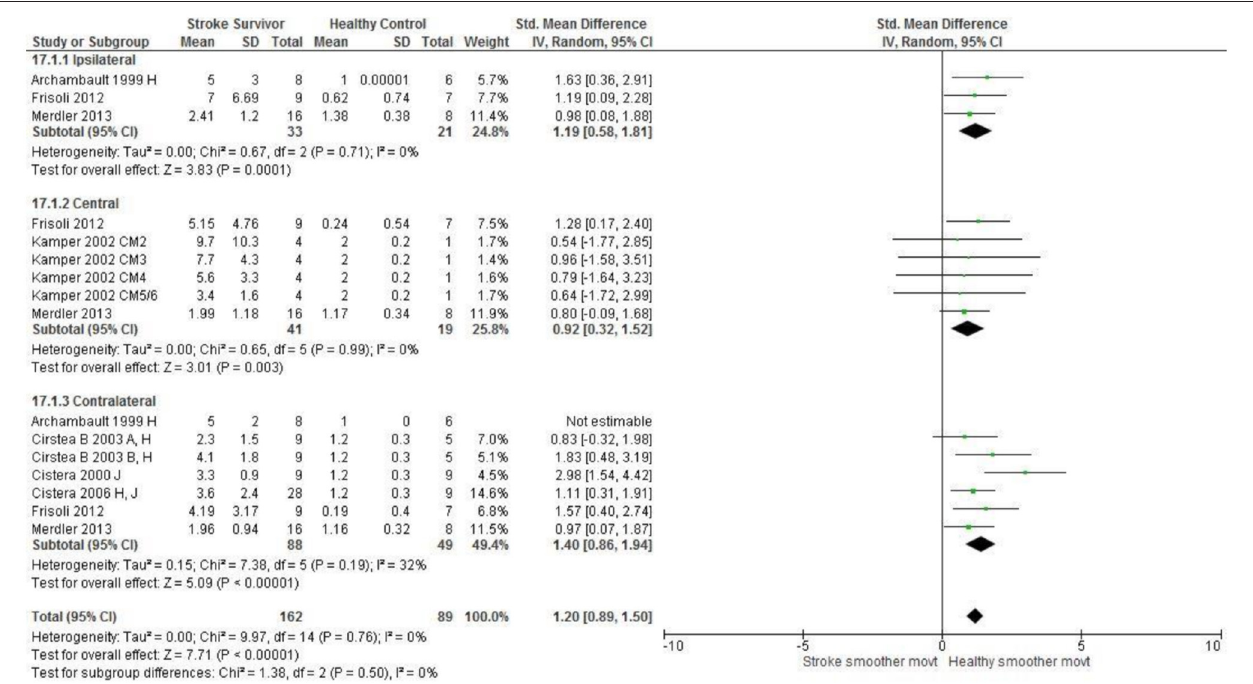
FIGURE 6 | The standardized mean difference (SDM) of movement smoothness during reach-to-target in the ipsilateral, central, and contralateral workspace. A, mild motor impairment; B, moderate motor impairment; H, fast speed; I, robotics; J, reaches without vision; M, virtual environment; CM, Chedoke-McMaster Stroke Assessment Scale; and corresponding stage